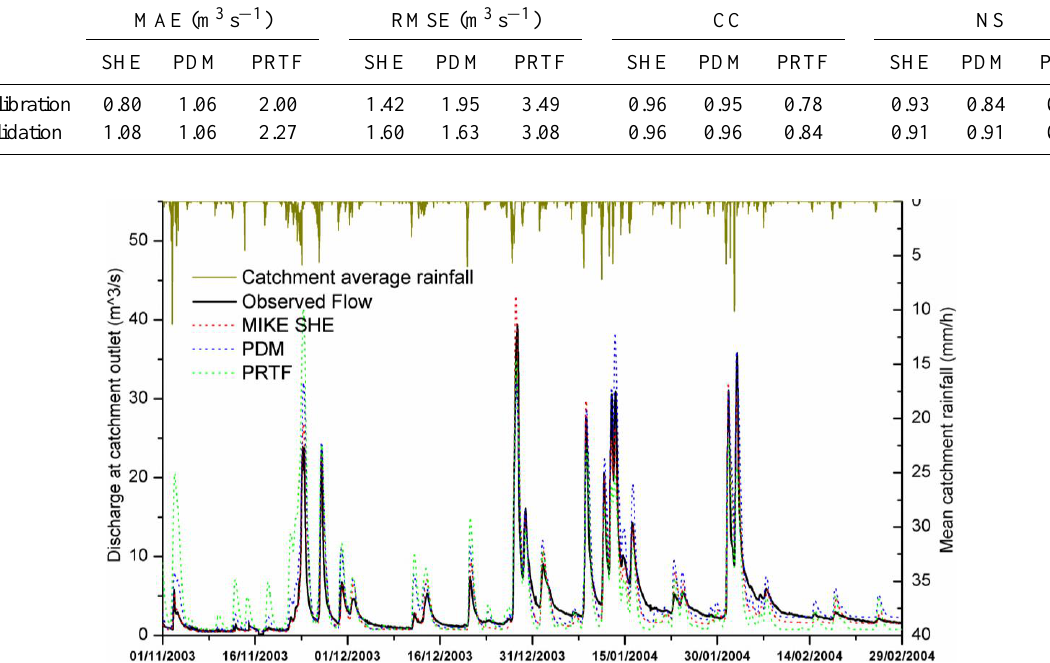
Fig. 2. The results of model calibration with raingauge